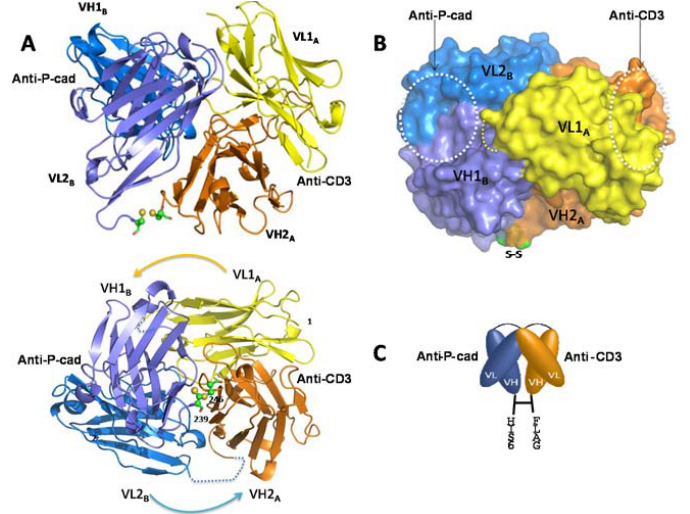
( C ) Schematic representation of the DART 35 used for crystallography studies. Pcad = P-cadherin; VH = Heavy chain variable region; VL = Light chain variable region; S–S = Disulfide